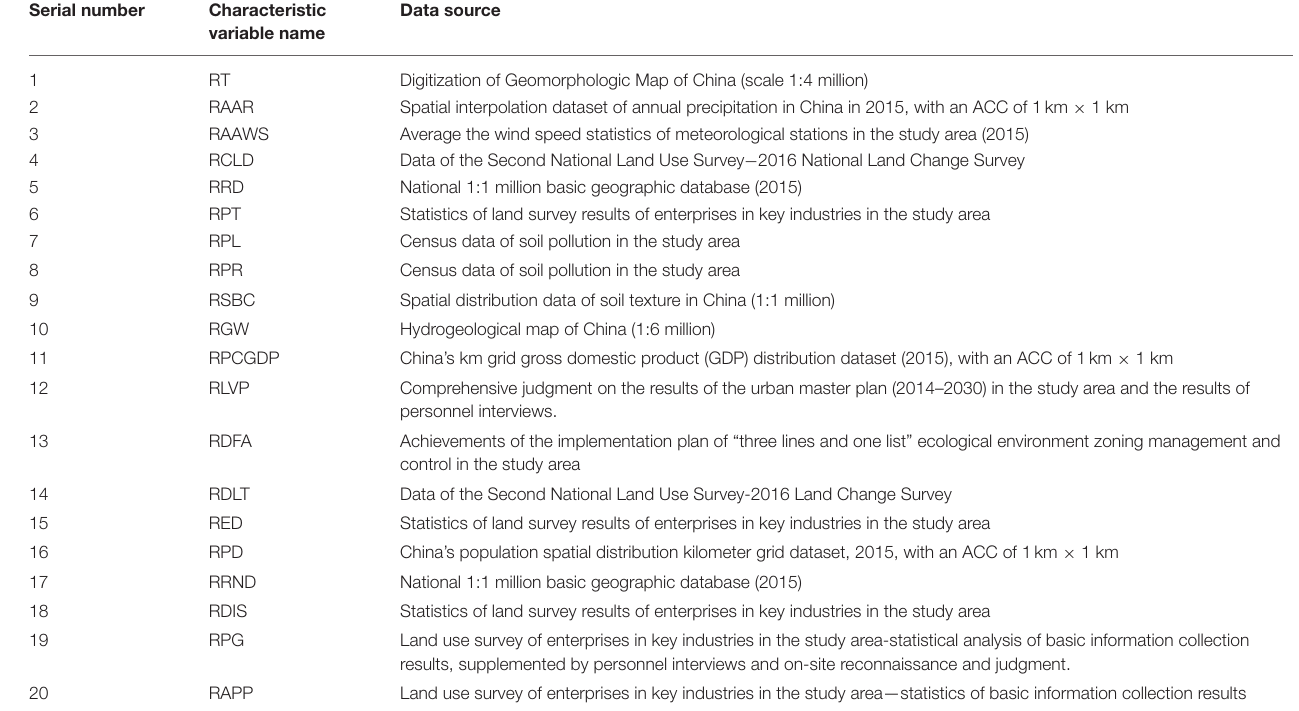
TABLE 2 | Statistical list of data